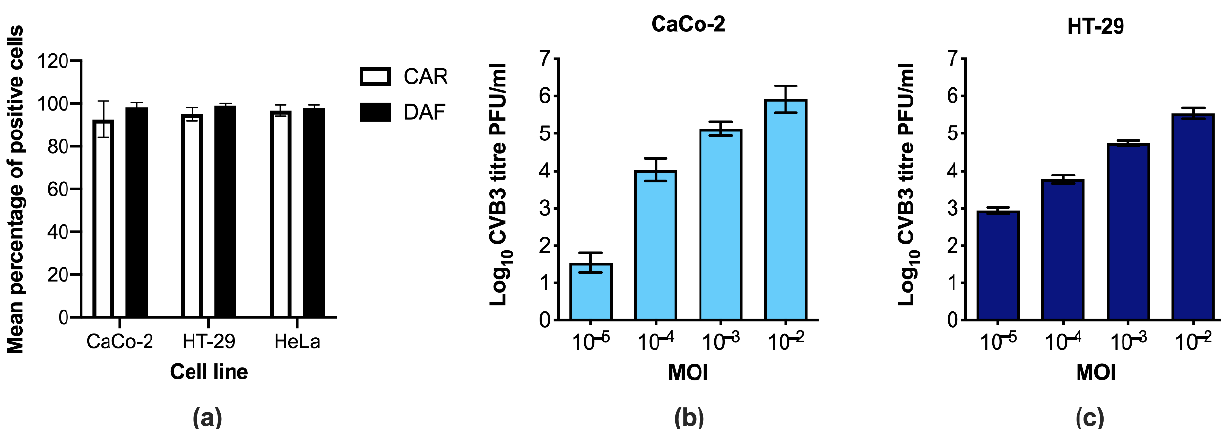
Figure 1. Intestinal epithelial cells (IECs) express Coxsackievirus and adenovirus receptor (CAR) and decay-accelerating factor (DAF) and can be infected by Coxsackievirus B3 (CVB3) in a dose-dependent manner. ( a ) The expression levels of the enterovirus receptors Coxsackie and adenovirus (CAR) and decay-accelerating factor (DAF) were assessed in CaCo-2 and HT-29 IECs by flow cytometry. At least 50,000 cells were screened in each experiment (CaCo-2 n = 7, HT-29 n = 7, HeLa n = 4). Shown are means ± SD. ( b ) CaCo-2 and ( c ) HT-29 cells were infected with 10 −5 to 10 −2 multiplicity of infection (MOI) CVB3 for 24 h and virus replication in the cells and supernatant was measured 24 h p.i. by standard plaque assay. Data are presented as mean plaque forming unites (PFUs) ± SD from three independent experiments per cell line. Significant increases in virus titers were observed in all pair-wise comparisons ( p < 0.05, one-way ANOVA).